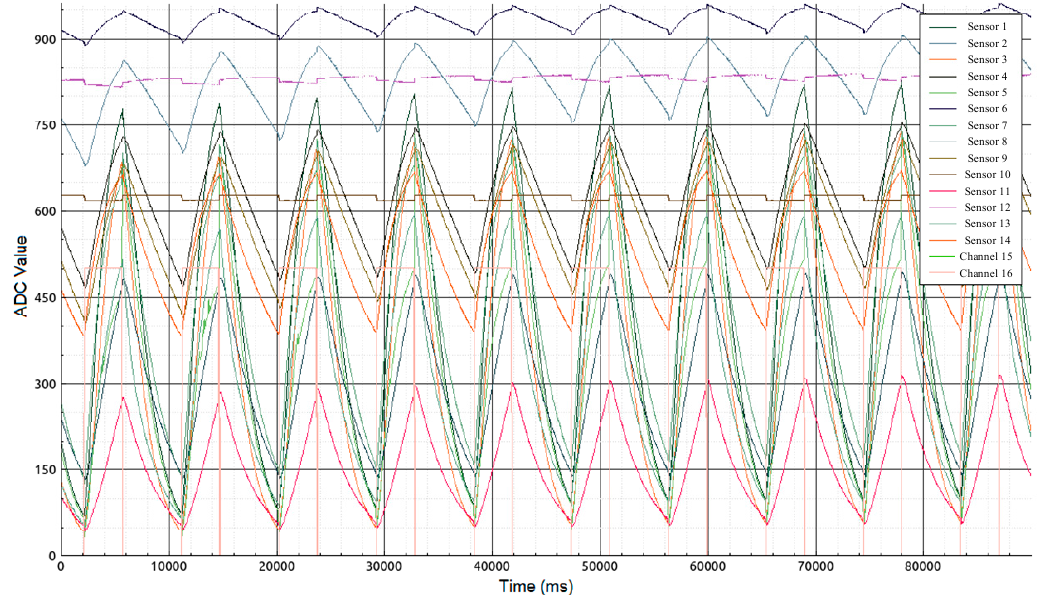
Figure 1. Form of sensor signals (ADC—analog-to-digital converter).